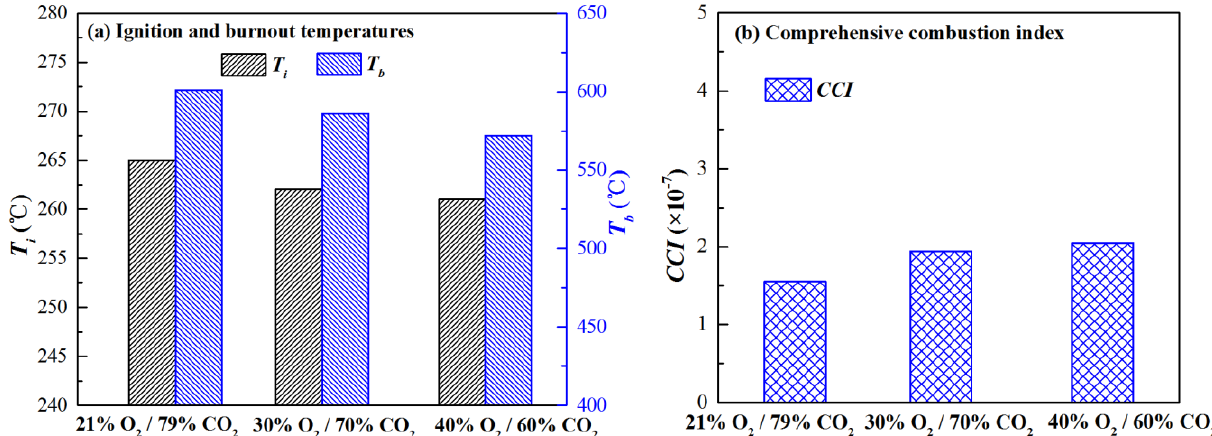
Figure 6. Ignition and burnout temperatures, CCI of 50% SHC + 50% ST under different O 2 concentrations.